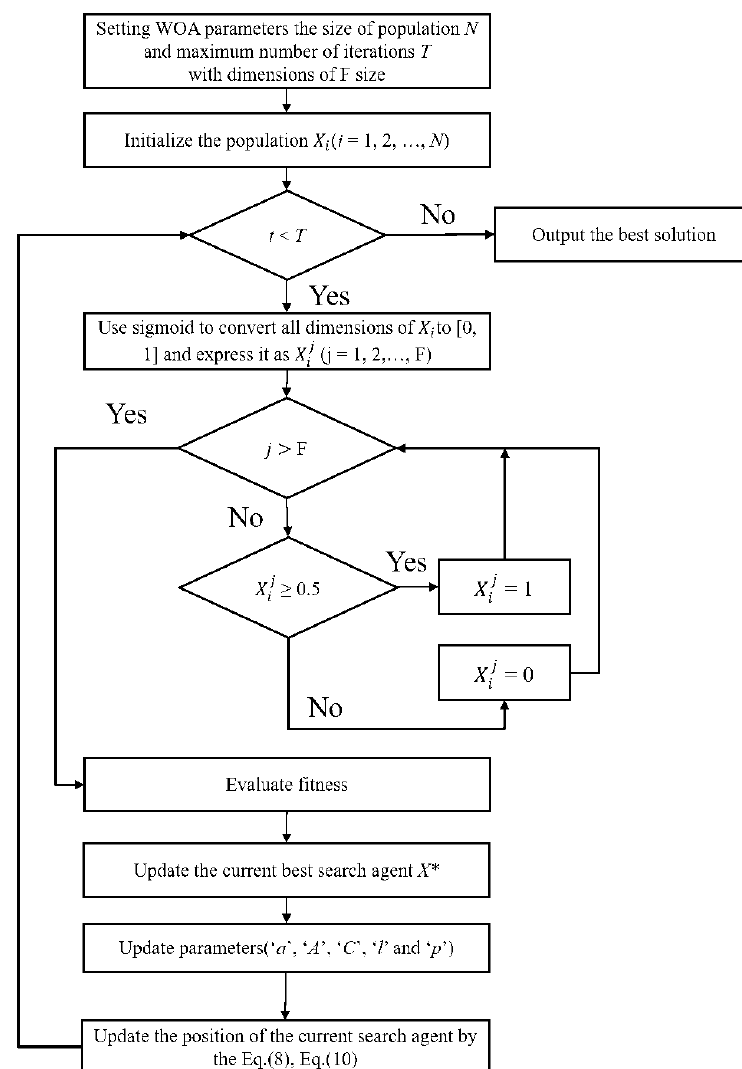
Figure 1. WOFS model flowchart.